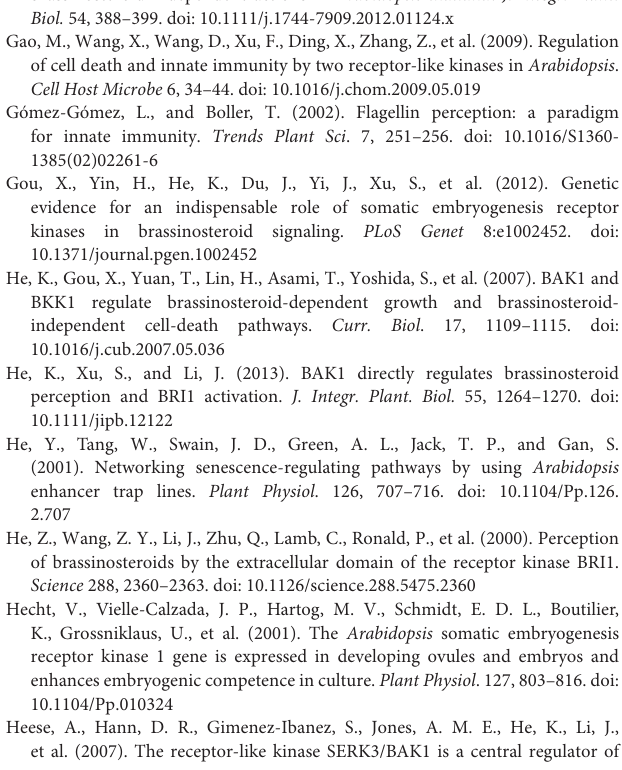
Figure S1 | Western blotting to confirm the expressed protein by transgenes in different genetic background by using FLAG antibody. (A) Overexpression of SERK5 -L er in bri1-5 . (B) Overexpression of SERK5 -L er in bak1-3 bkk1-1 . (C) Overexpression of kinase-death forms of SERK5 -L er in bri1-5 . Figure S2 | Overexpression of SERK5 -L er in bri1-5 is unable to rescue the root and hypocotyl phenotypes of bri1-5. (A) Statistic analyses of the average petiole lengths of 30-day-old WT, bri1-5 and bri1-5 lines overexpressing SERKs . (B,C) Statistic analyses of root and hypocotyl lengths of 8-day-old seedlings grown on 1/2 MS medium in light and dark, respectively. Overexpression of BKK1 can partly recue the petiole phenotype, but not the root and hypocotyl phenotypes of bri1-5 . Overexpression of SERK5 -L er recues none of the petiole, root and hypocotyl phenotypes of bri1-5 . The data are shown as means ± standard deviation (SD) ( n ≧ 40). Student’s t -test indicated the differences are statistically significant ( ∗∗∗ P < 0.001 , ∗∗ P < 0.01 ). Experiments were repeated three times with similar results. Figure S3 | Overexpression of SERK5 -L er in bri1-5 is unable to enhance the sensitive of bri1-5 to BL. (A) Root growth analysis of 8-day-old seedlings grown on 1/2 MS medium containing different concentrations of 24-epiBL in the light. (B) Hypocotyl growth analysis of 8-day-old seedlings grown on 1/2 MS medium containing different concentrations of 24-epiBL in the dark. The data are shown as means ± standard deviation (SD) ( n ≧ 40). Experiments were repeated three times with similar